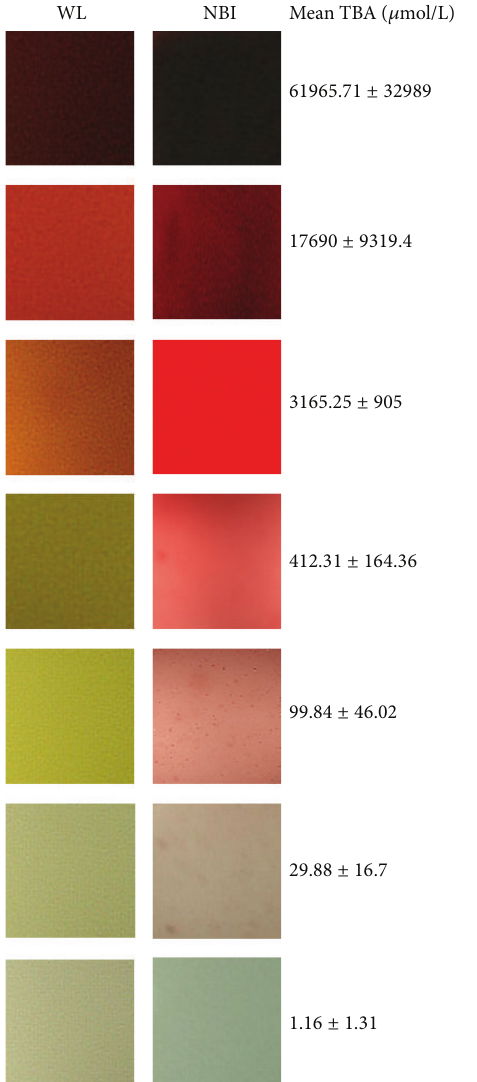
Figure 2: Bile concentration scale on white light (WL) and NBI. Each correspondent mean TBA concentration is reported on the